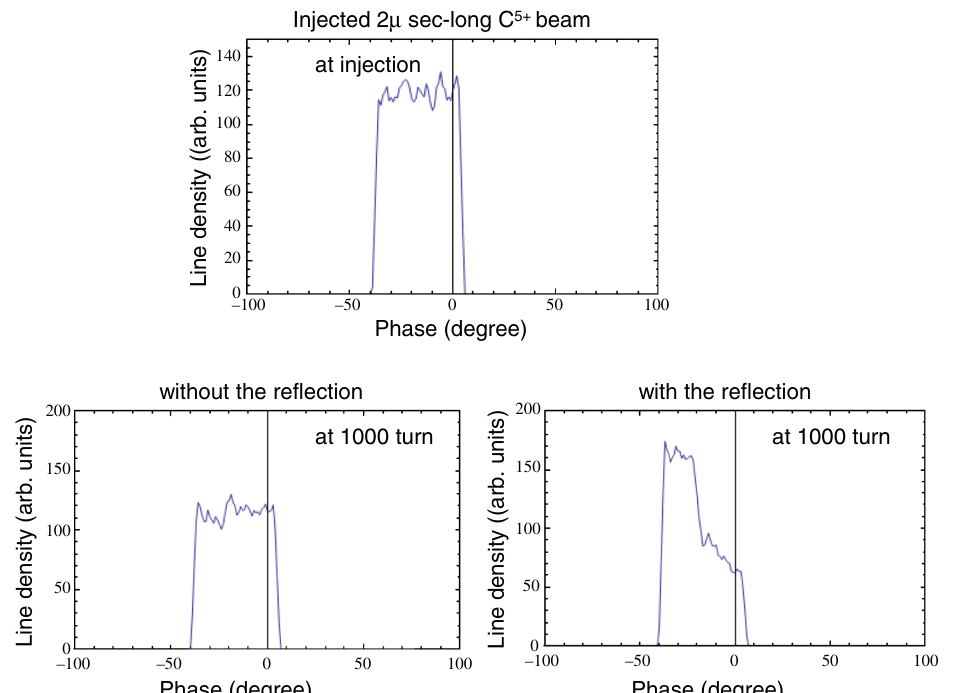
turns.FIG. 14. (Upper) Model barrier voltage pulse with a reflection and (bottom) phase-space struture of the barrier bucket disturbed by the reflection